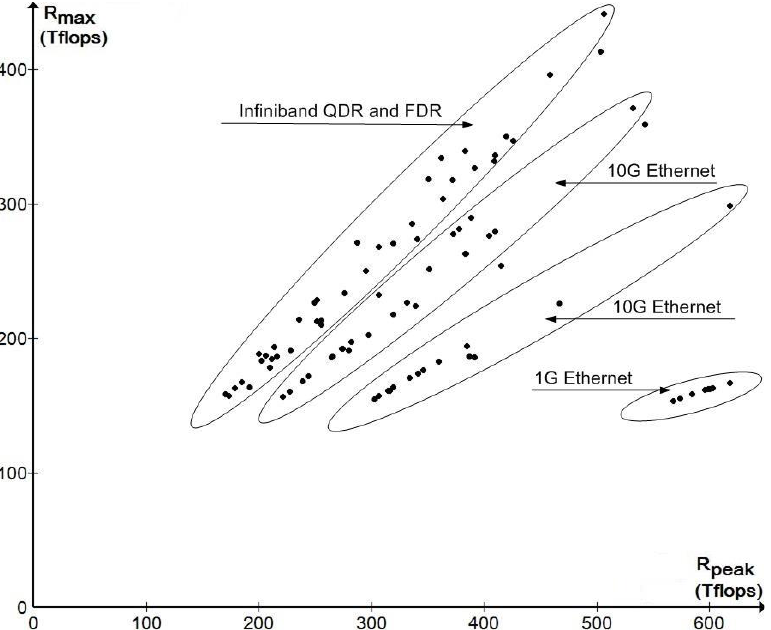
Figure 1. Dependence of R max on R peak in clusters based on Intel Xeon E5-2670 without accelerators (November 2014 TOP500).